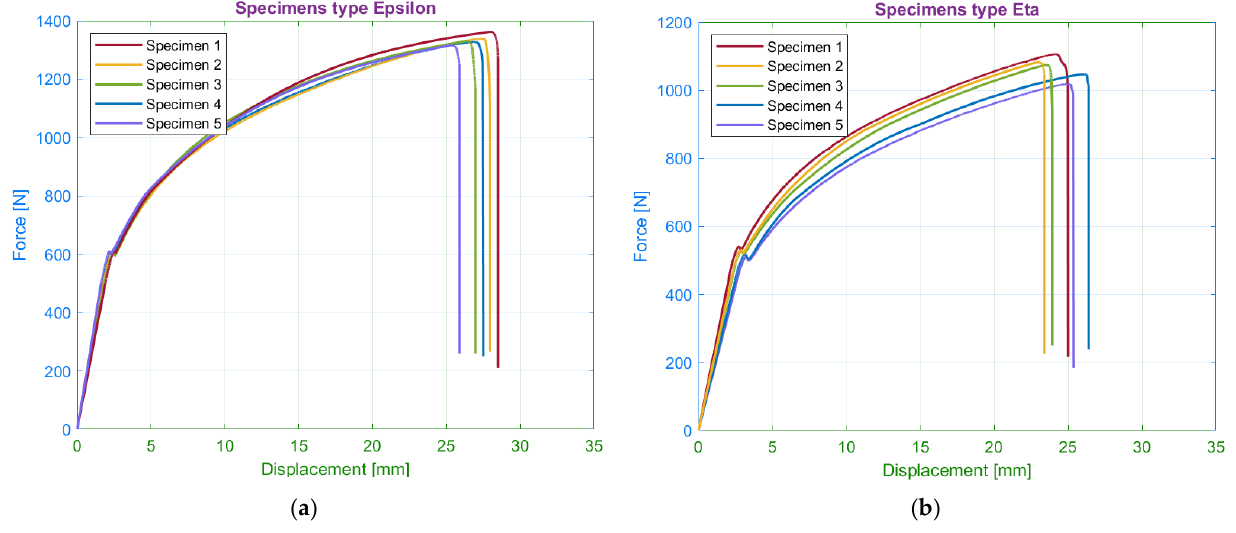
Figure 21 . Tensile diagrams for specimens with ( a ) 10 roof/floor layers; ( b ) 0 roof/floor layers.